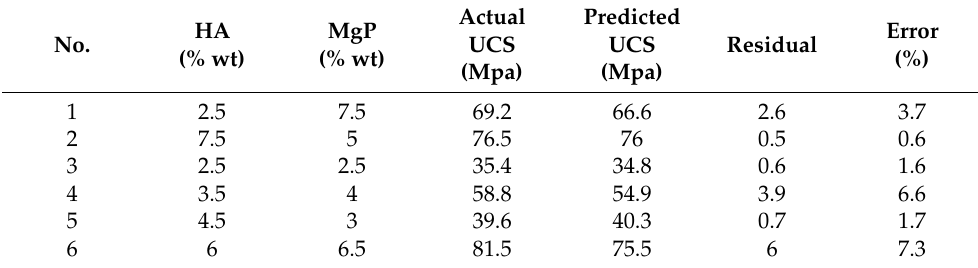
Table 6. The confirmation tests for